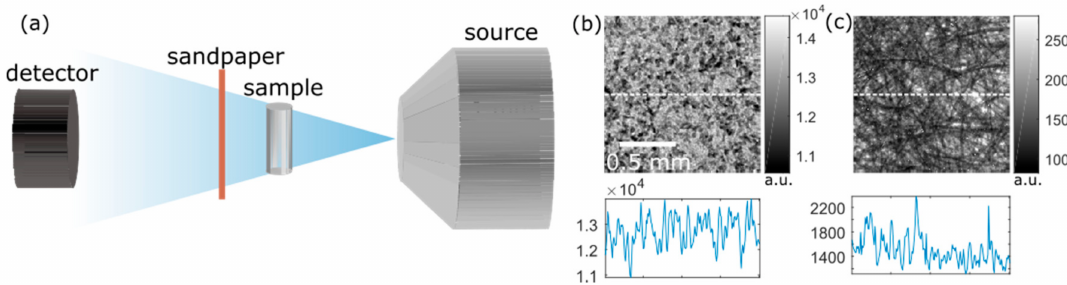
Figure 1. ( a ) Illustration of the experimental alignment. X-ray image of ( b ) sandpaper and ( c ) steel wool, and profiles from the dashed